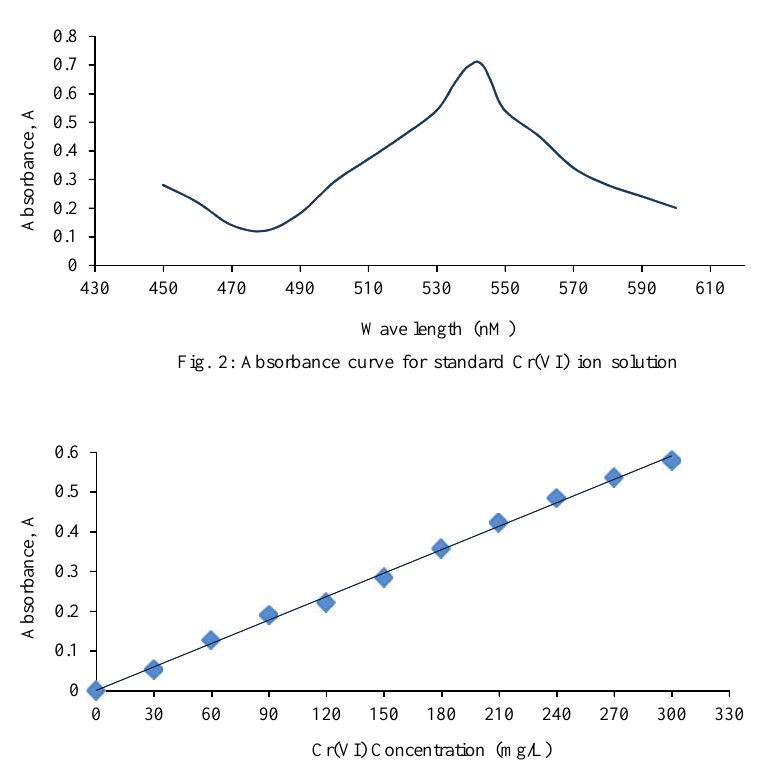
Fig. 3: Calibration curve for standard Cr(VI) ion solution for the maximum absorbance wavelength of 542